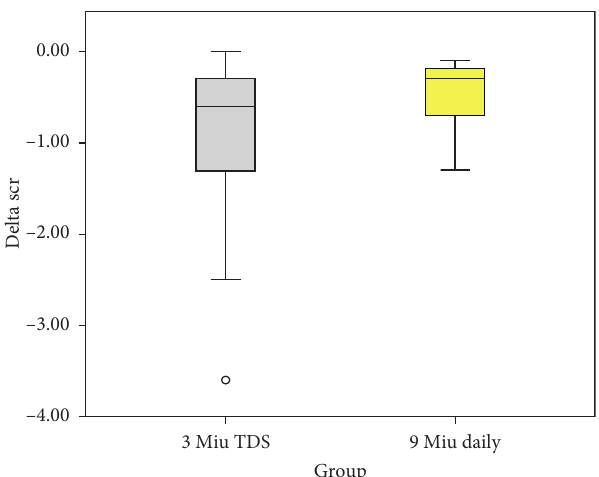
Figure 2: Box plot of SCr changes from baseline levels to the